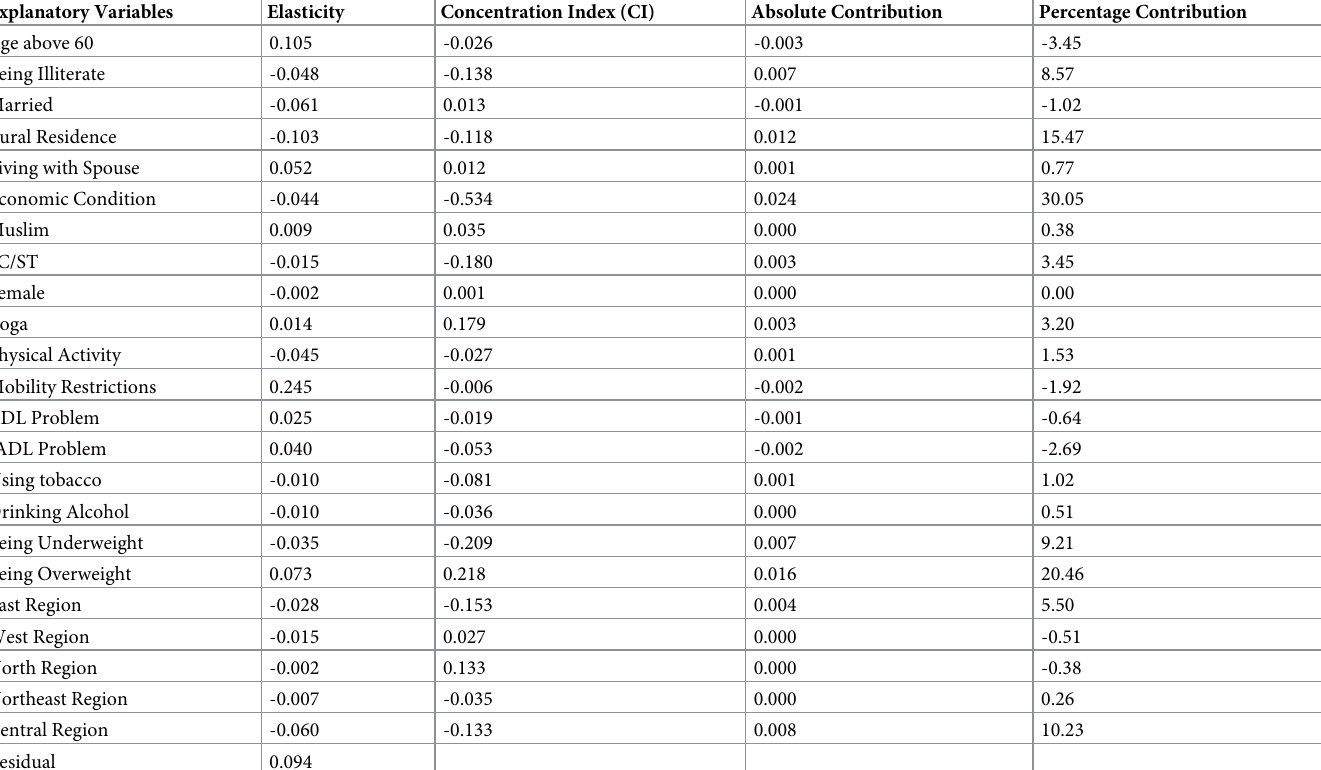
Table 6. Estimation of decomposition analysis for contribution of various explanatory variables for non-communicable diseases among older adults in India, 2017–